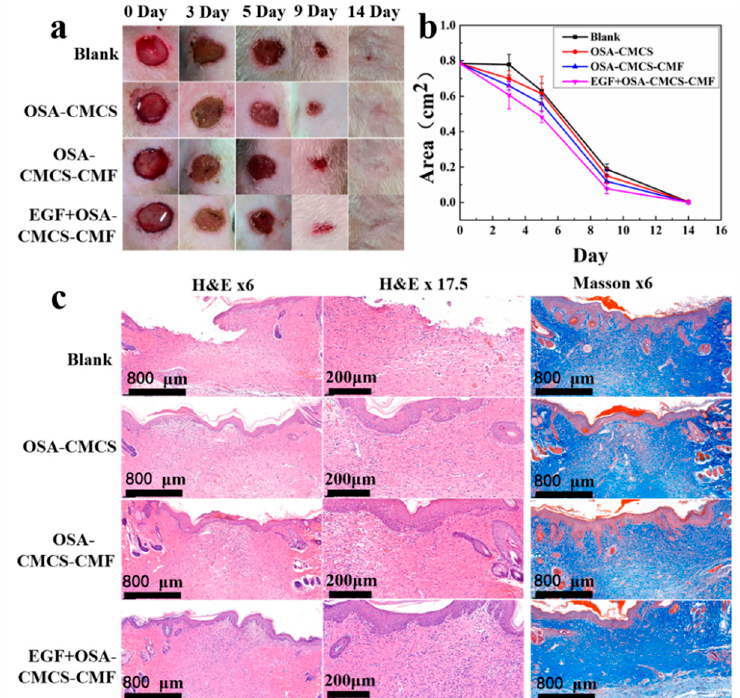
Figure 5. ( a ) Photos of the blank control, OSA-CMCS, OSA-CMCS-CMF, and EGF-OSA-CMCS-CMF treatments showing the repair of back skin defects in rats after 0, 3, 5, 9, and 14 days. ( b ) Statistical maps of the change in defect area during the wound healing process. ( c ) Images of wound pathological staining after 14